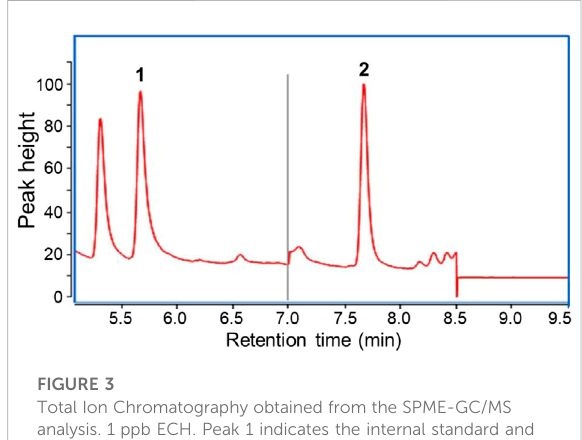
FIGURE 3 Total Ion Chromatography obtained from the SPME-GC/MS analysis. 1 ppb ECH. Peak 1 indicates the internal standard and peak 2 indicates the